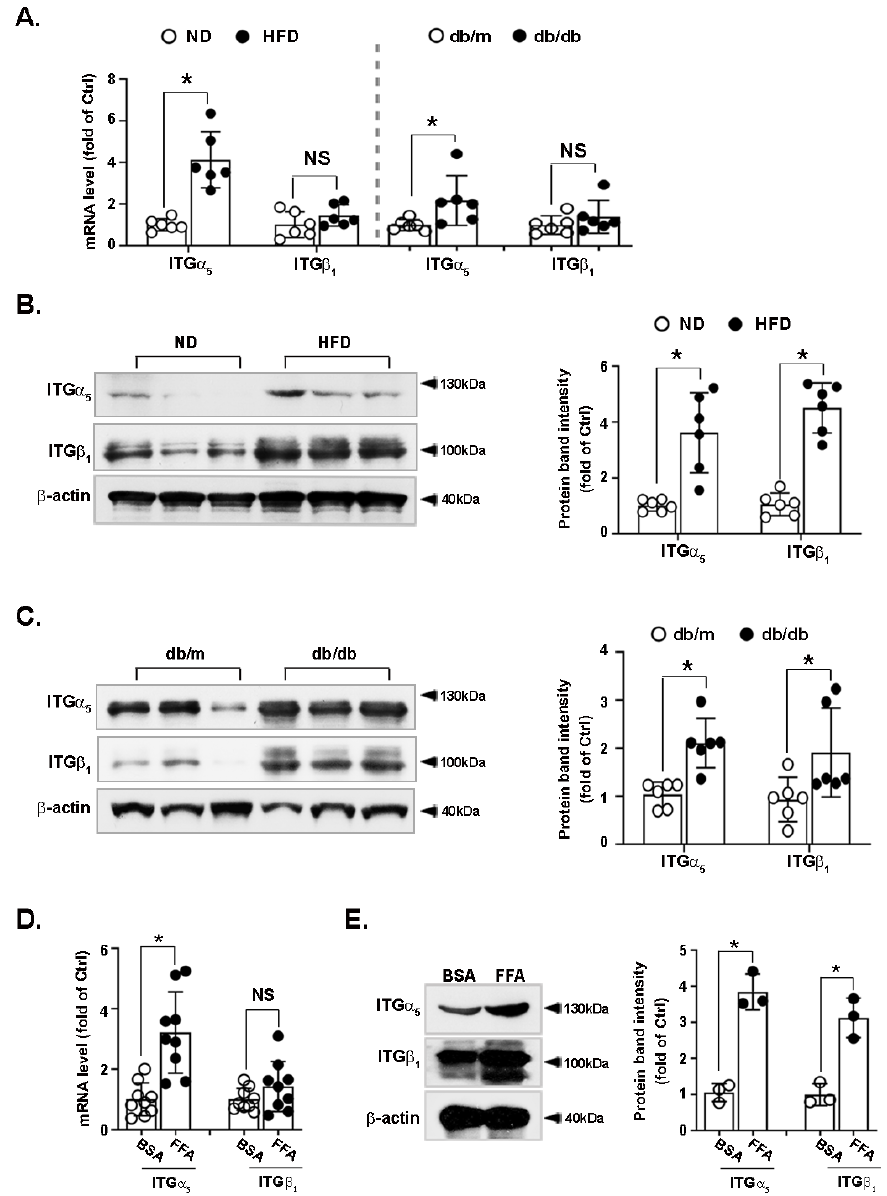
Figure 4. Expression of integrin α 5 and β 1 in the liver of obese mice and in FFA-treated hepatocytes. Mice fed a ND or HFD for 16 weeks (n = 6 in each group) and db/db and db/m mice (8 weeks old, n = 6 in each group) were sacrificed. The livers were immediately dissected and subjected to quick-freezing in liquid nitrogen. The mRNA levels of integrin α 5 and β 1 ( A ) were measured by RT-qPCR. The protein levels of integrin α 5 and β 1 in the livers of ND and HFD mice ( B ) and db/m and db/db mice ( C ) were measured by immunoblotting. LO2 hepatocytes were treated with FFA (1 mM) for 24 h. Levels of integrins α 5 and β 1 in the cell lysates were analyzed using ( D ) RT-qPCR and ( E ) immunoblotting. RT-qPCR data shown are from three independent experiments performed in triplicate. Immunoblots shown are representative of three independent experiments. Quantifications of band intensity were normalized to β -actin. * p < 0.05, NS: not significant. ITG α 5 : integrin α 5 ; ITG β 1 : integrin β 1